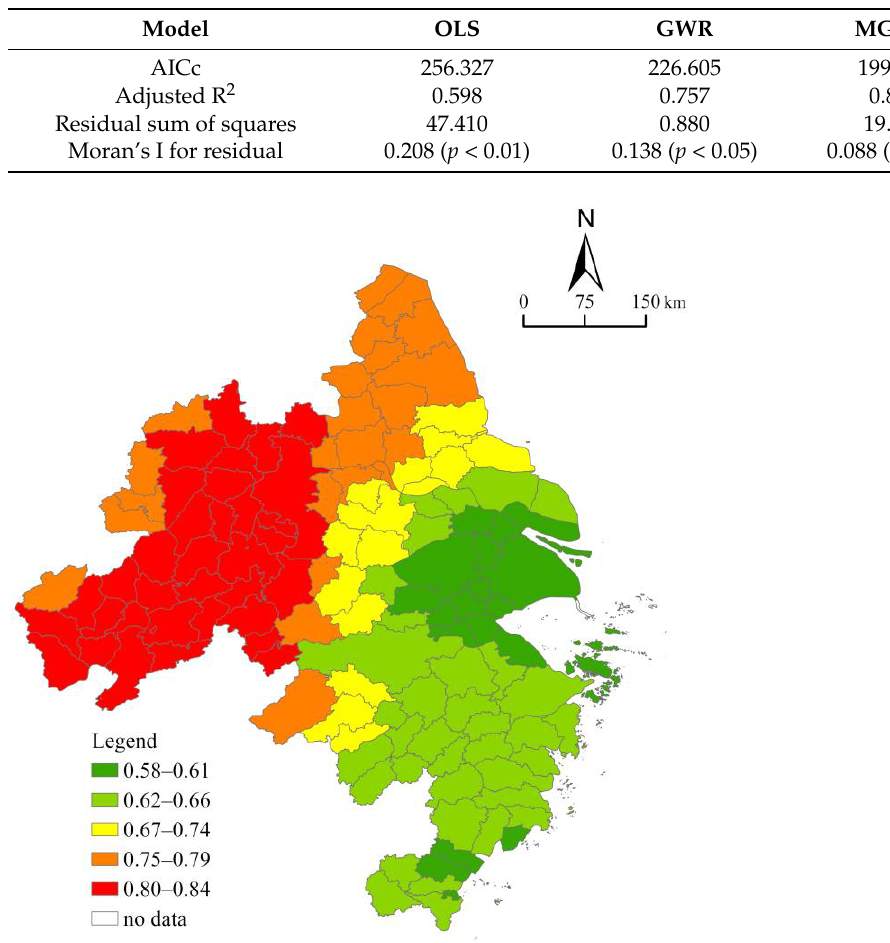
Table 3. Comparison of OLS, GWR and MGWR fitting results.